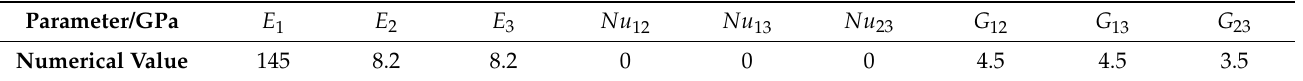
Table 3. Properties of uniaxial fiber material.